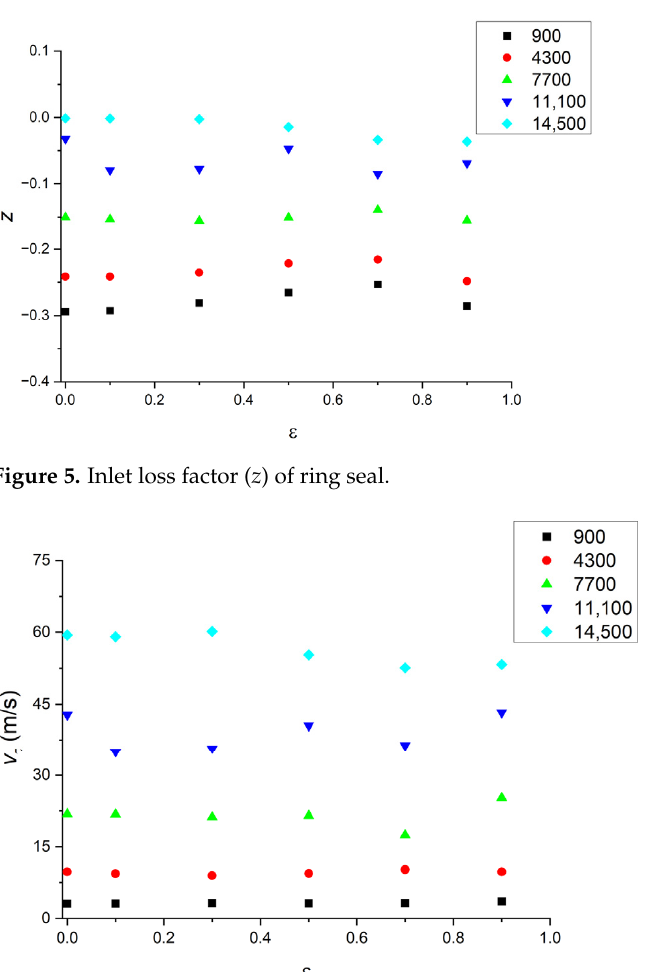
Figure 4. Average value of fluid axial speeds ( v z ) of ring seal (Unit: m/s).